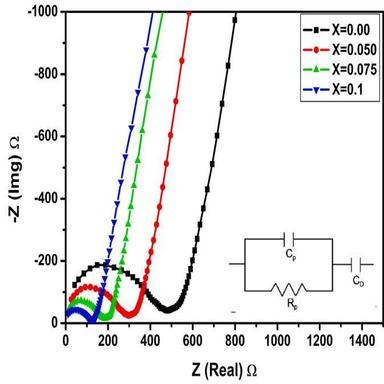
Nyquist plots for CoFe2-xSmxO4 (x = 0.0, x = 0.050, x = 0.075 and x = 0.1) ferrite composite.